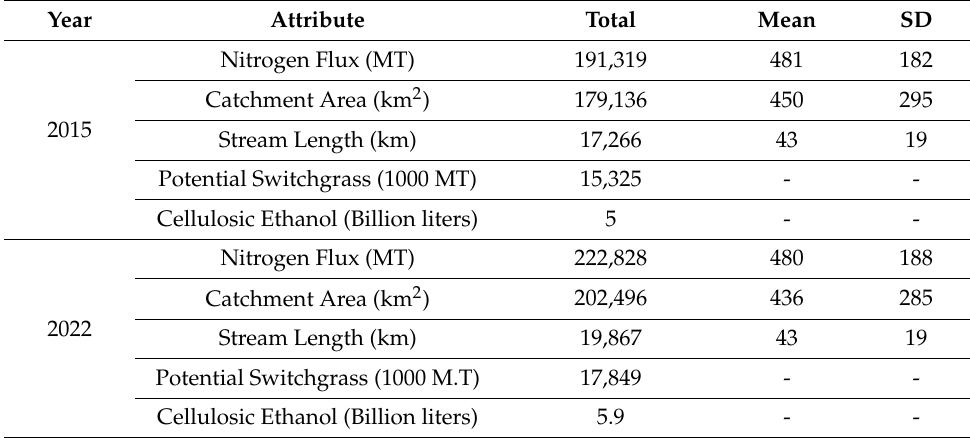
Table 4. Average nitrogen flux, switchgrass production and potential cellulosic ethanol from high impact